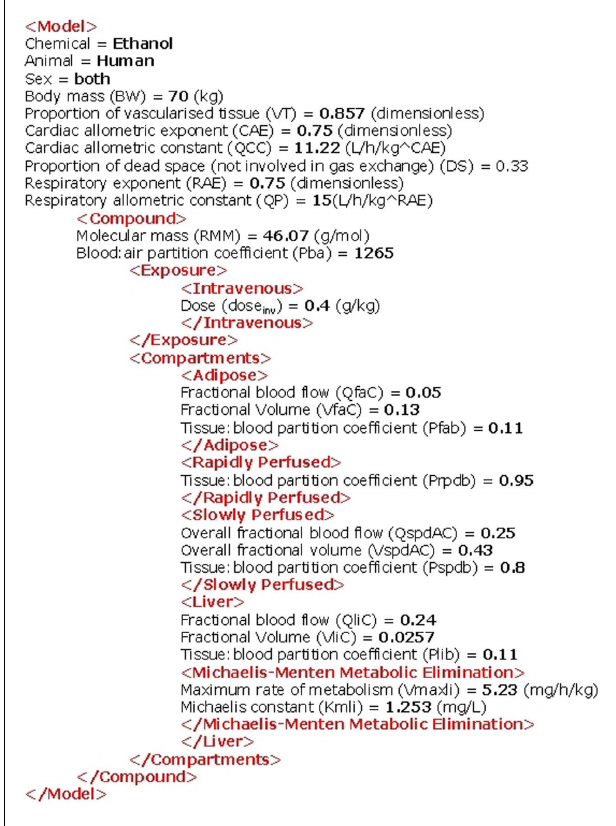
FIGURE 11 |A conceptual view of the data schema showing the hierarchical arrangement of parameter groupings.